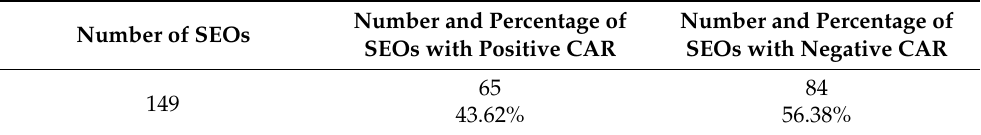
Table 1. Effects of seasoned equity offerings (SEOs) on share price (uncategorized) for the total